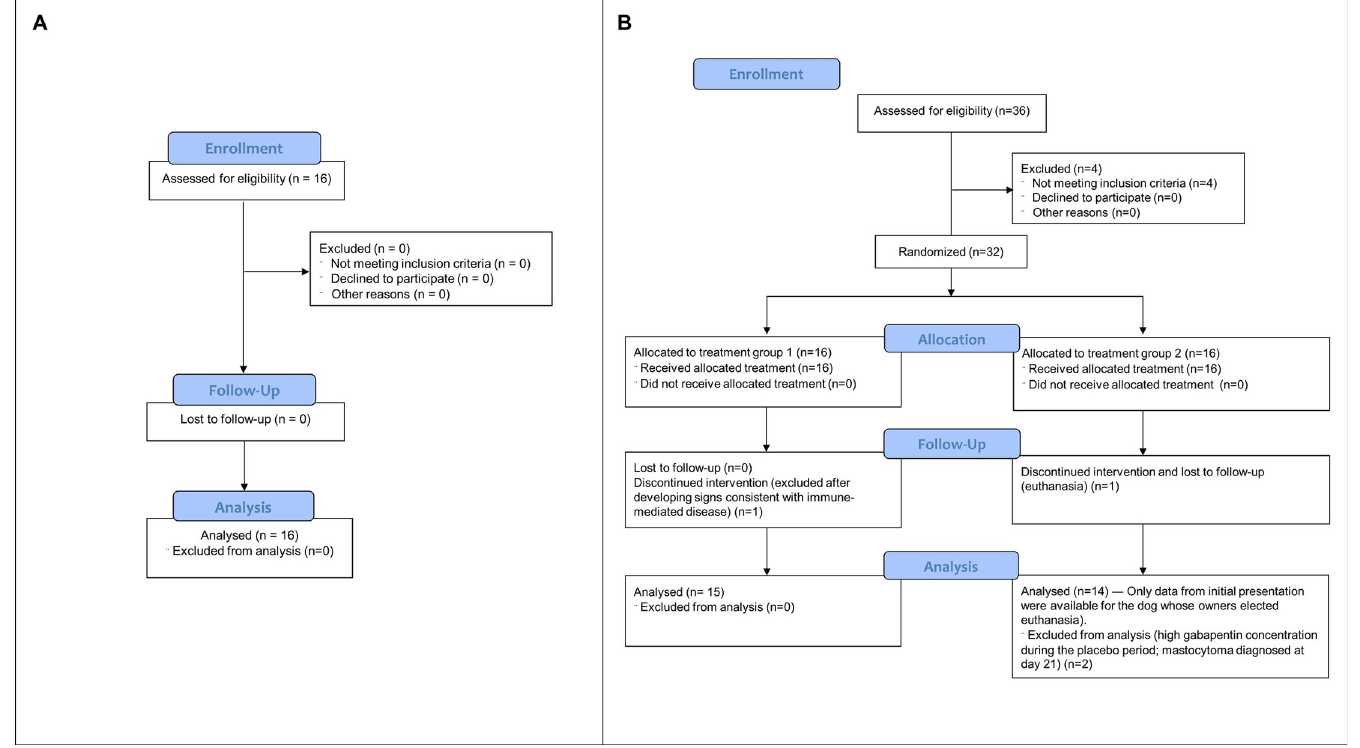
Fig 2. CONSORT Flow Diagram showing the flow of a) healthy dogs and b) dogs with neuropathic pain through the study.